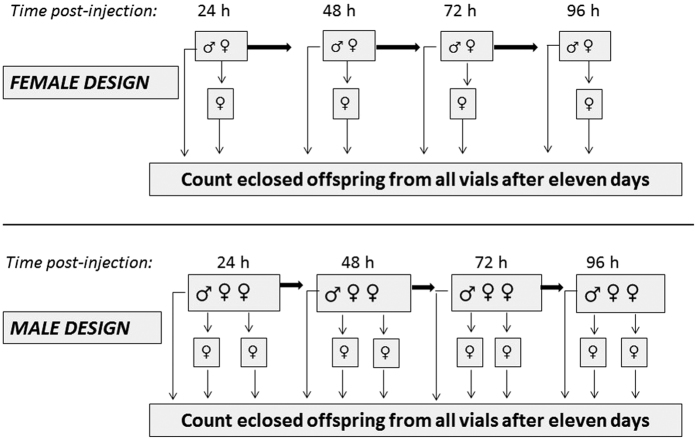
Outline of experimental design for both sexes.Females were transferred to new ovipositing vials every 24 h, each of which was retained for eleven days, at which point eclosing offspring were counted.